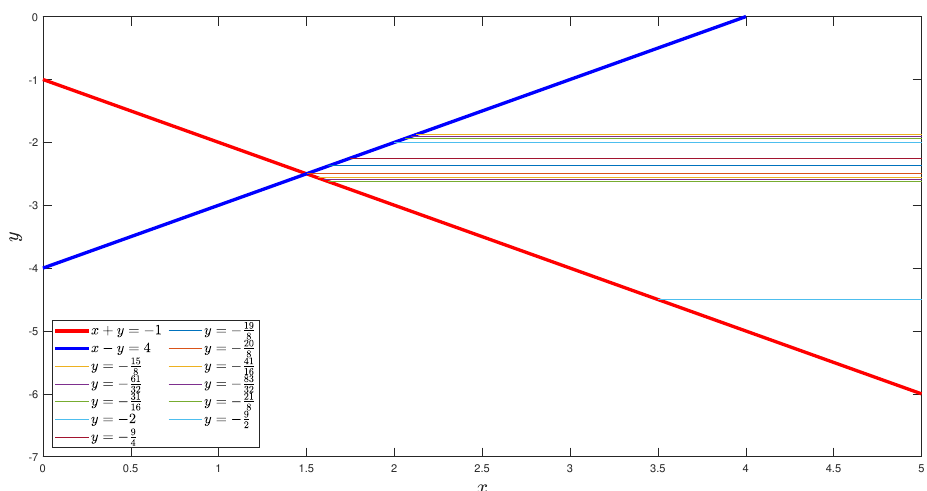
Figure 5. Regions considered in the proof of Case